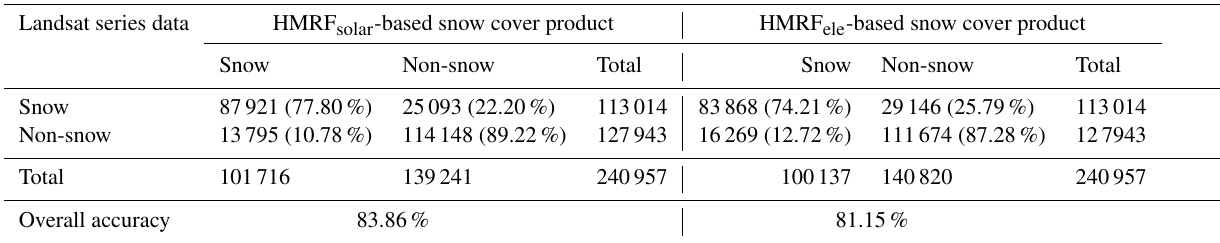
Table 4. Confusion matrices between HMRF solar -based snow cover products, HMRF ele -based snow cover products, and snow cover mapped from Landsat series data products for data-gap pixels during